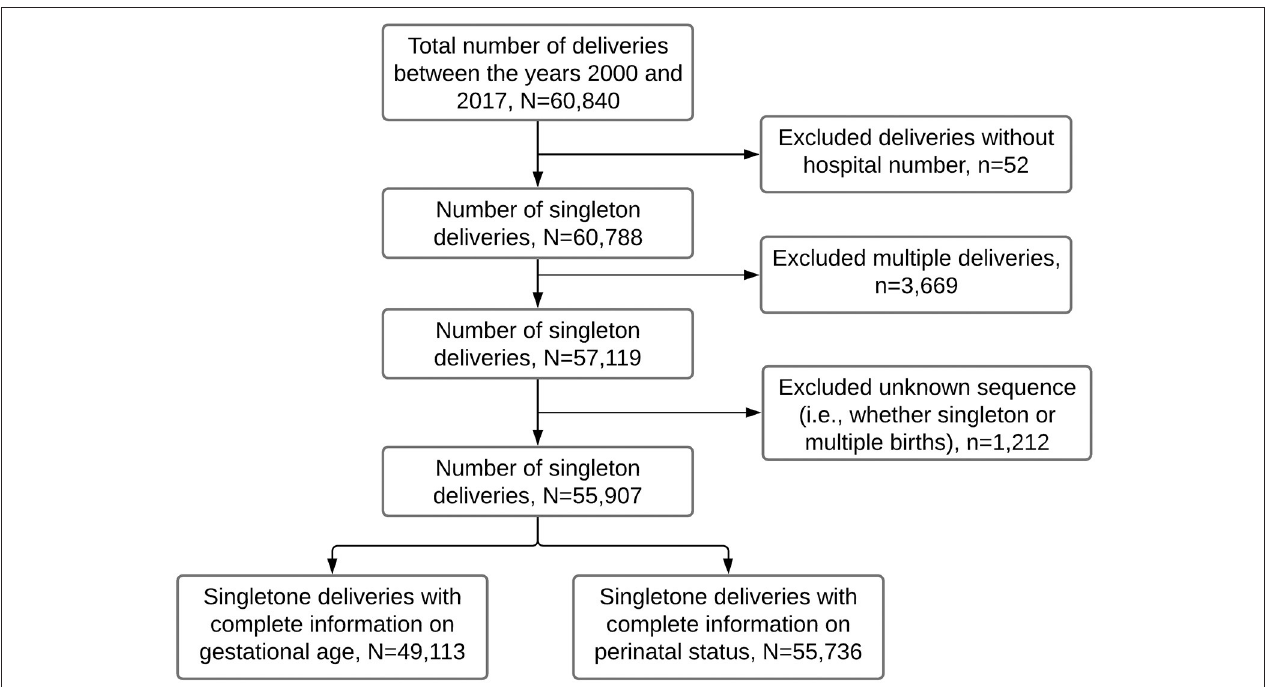
FIGURE 1 | Flow chart showing the number of singleton deliveries analyzed in this study. Data from the Kilimanjaro Christian Medical Center (KCMC) Medical birth registry,